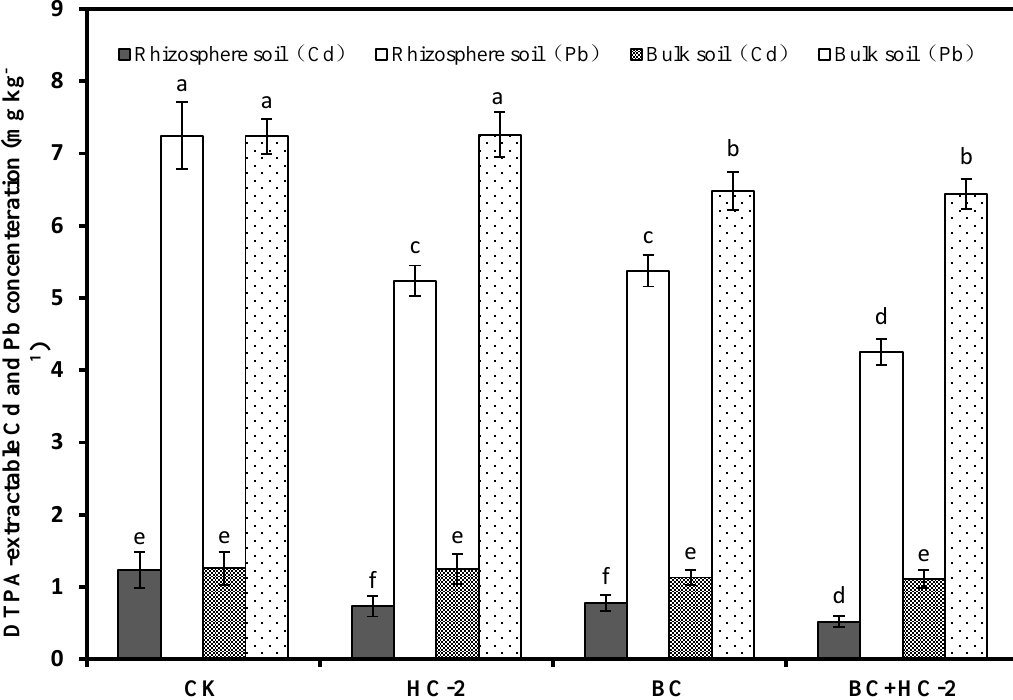
Figure 3. E ff ects of strain HC-2, BC, and BC + HC-2 on the DTPA-extractable Cd and Pb contents in Figure 3. Effects of strain HC-2, BC, and BC+HC-2 on the DTPA-extractable Cd and Pb contents in the the rhizosphere and bulk soils of radish. Error bars are ± standard error ( n = 3). Bars indicated by rhizosphere and bulk soils of radish. Error bars are ± standard error (n = 3). Bars indicated by the the di ff erent letters for each Cd and Pb contents were significantly ( p < 0.05) di ff erent according to different letters for each Cd and Pb contents were significantly ( p < 0.05) different according to Tukey’s Tukey’s test.